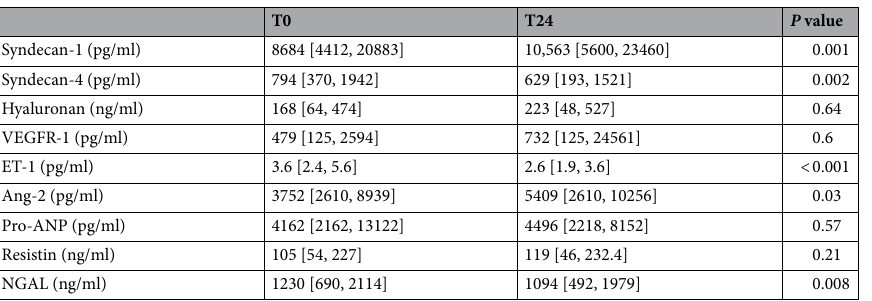
Table 2. Biomarker results. Values are medians [first to third quartile: Q1, Q3]. VEGFR Vascular Endothelial Growth Factor Receptor, ANP Atrial Natriuretic Peptide, NGAL Neutrophil Gelatinase-Associated Lipocalin. P values were obtained from unadjusted random effects Tobit or linear mixed models.